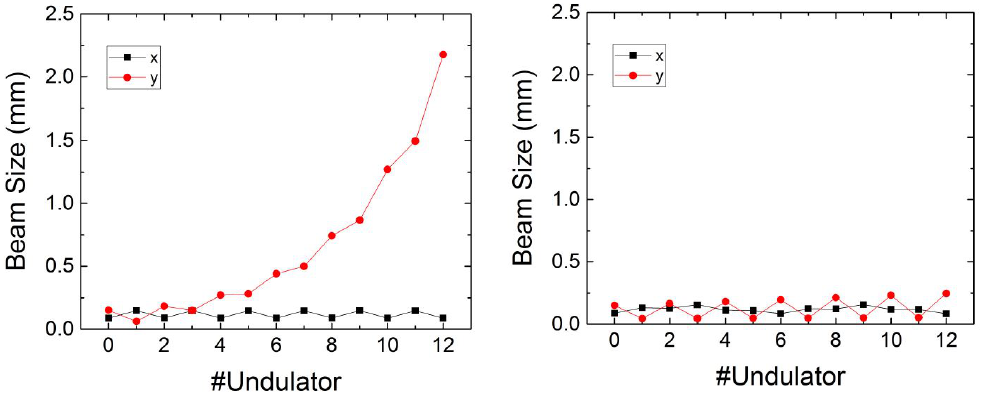
Figure 4. Simulated beam size (in mm) along the undulator without automatic adjustment (left ) and including adjusted focusing to compensate for the additional undulator focusing ( right ) for a beam energy of 380 MeV and an undulator K rms =